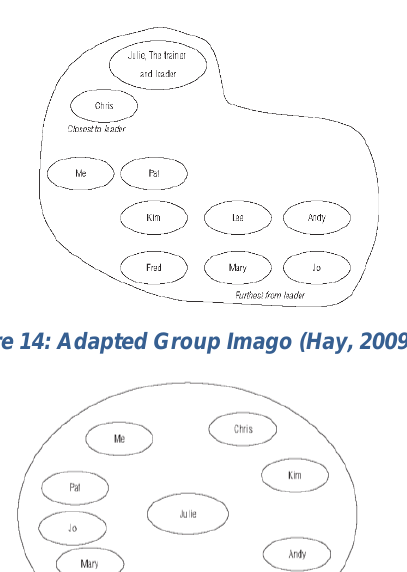
Figure 13: Adjusted Group Imago (Hay, 2009 p.172) (2009)